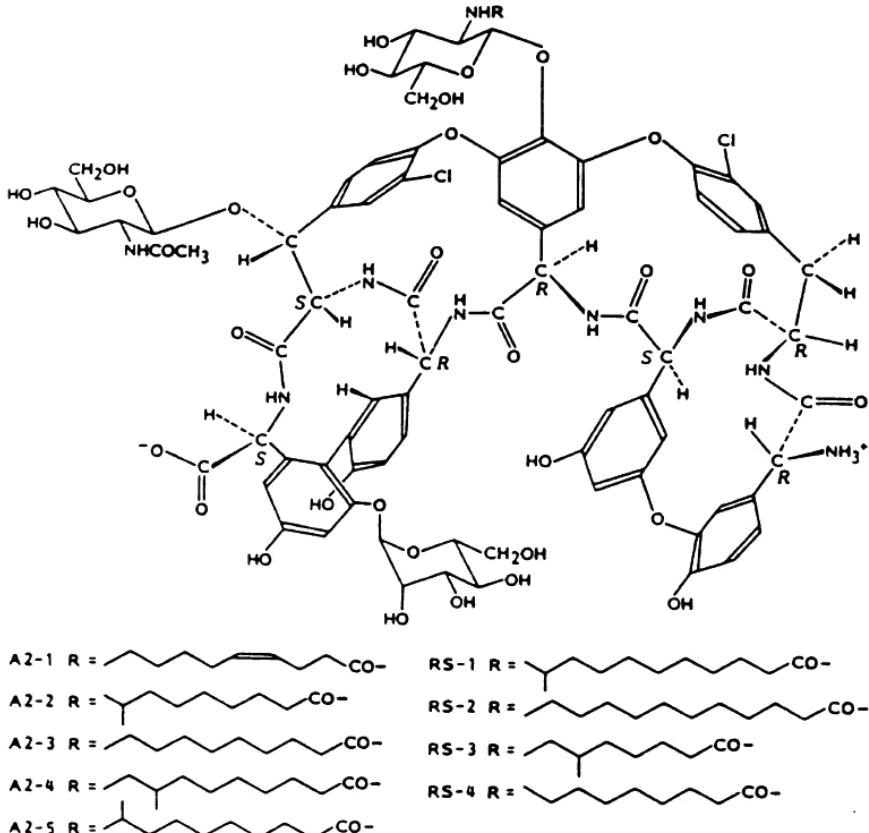
Fig. 1. Structure of